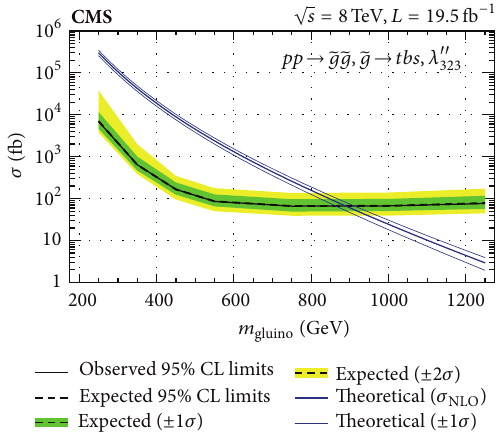
Figure 18: 95% CL upper limit on the gluino production cross section for a RPV simplified model, 𝑝𝑝 → ̃𝑔̃𝑔 , ̃𝑔 → 𝑡𝑏𝑠 (from